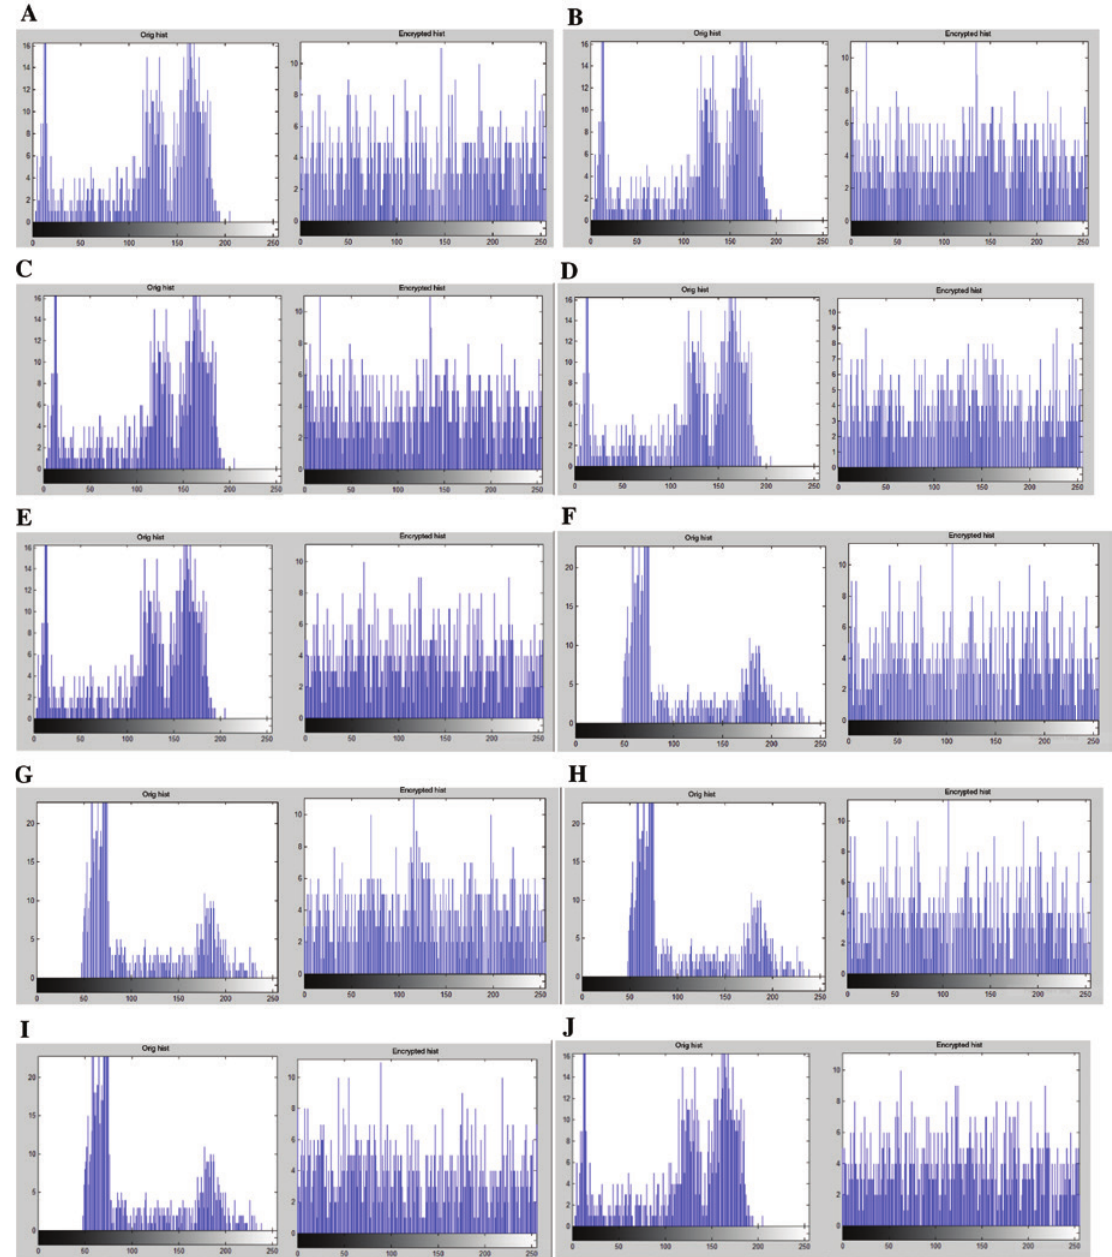
Figure 2: Histogram Analysis of Figure 1A–C Using Logistic